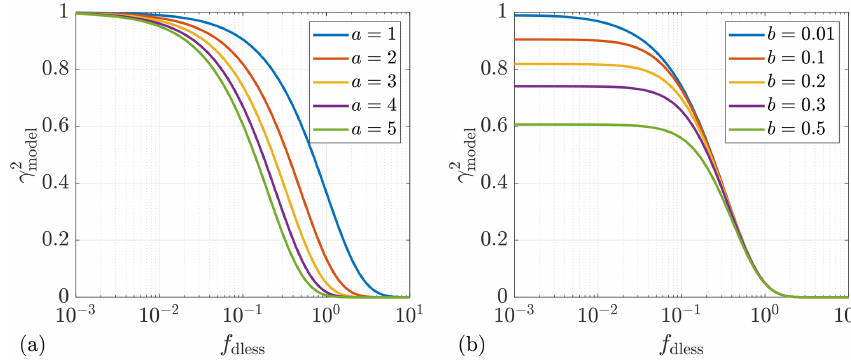
Figure 2. Impact of the model parameters a and b on the wind evolution model. (a) b = 0. (b) a =